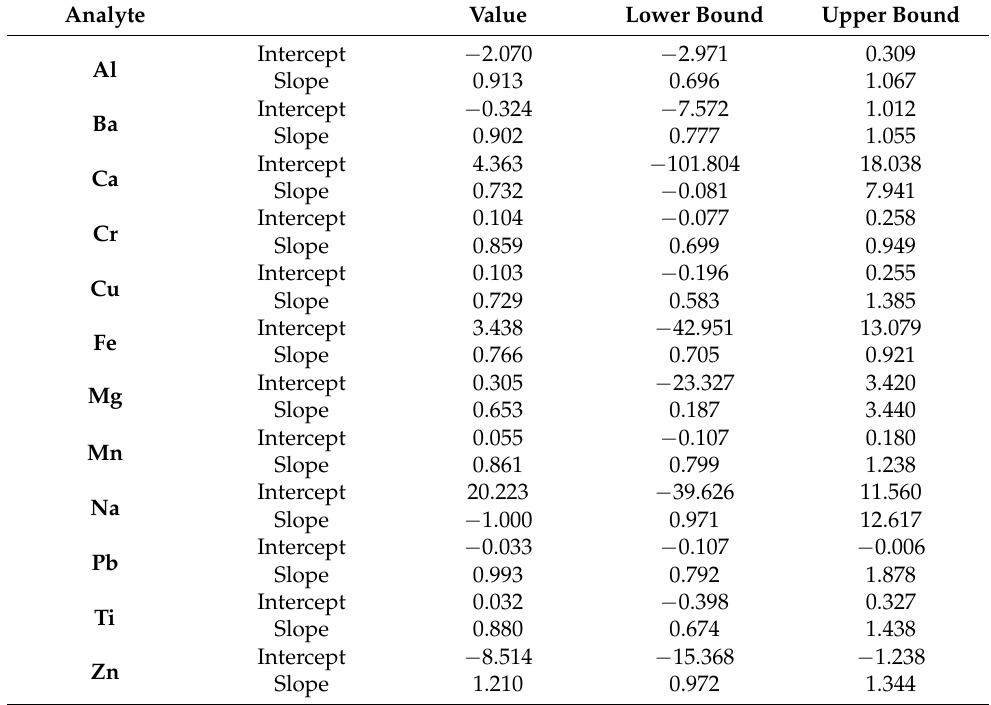
Table 4. Model coefficients obtained with Passing–Bablok regression at a confidence level of 95%.